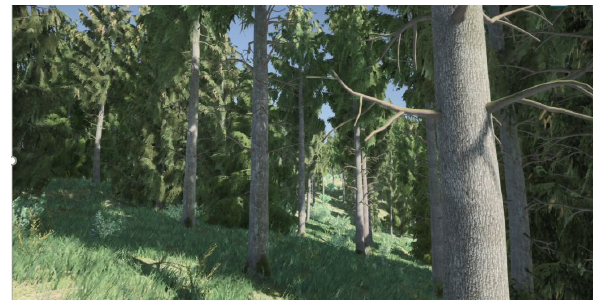
Figure 8 . Vegetation details generated through the UE Procedural Foliage Spawner. Pedestrian view